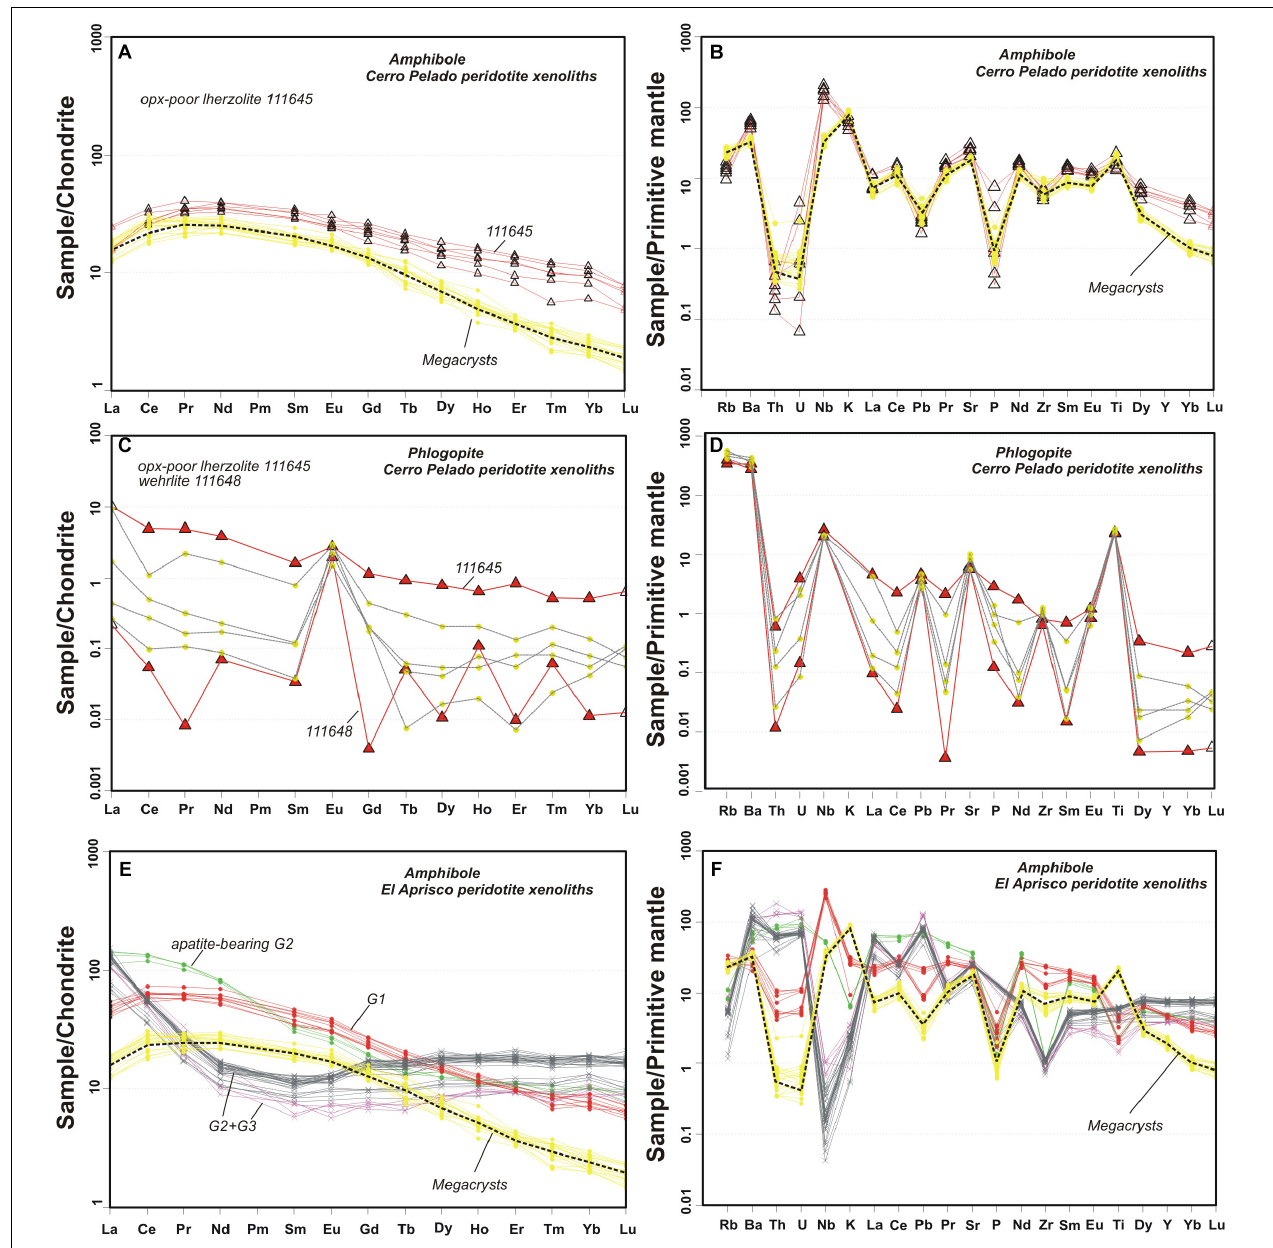
FIGURE 11 | Chondrite-normalized REE and primitive mantle-normalized trace element patterns of amphibole (A,B,E,F) and phlogopite (C,D) of peridotite xenoliths from studied volcanic centers. Amphibole trace element composition of mantle xenoliths (G1 to G3 groups) from the El Aprisco maar is taken from Villaseca et al. (2010, 2019b) and González-Jiménez et al. (2014). Those from the Cerro Pelado scoria cone are unpublished data. Amphibole megacryst field (in yellow) and the average (black line) is taken from Figure 8 . Chondrite values are from Boynton (1985) whereas primitive mantle normalizing values are from Sun and McDonough